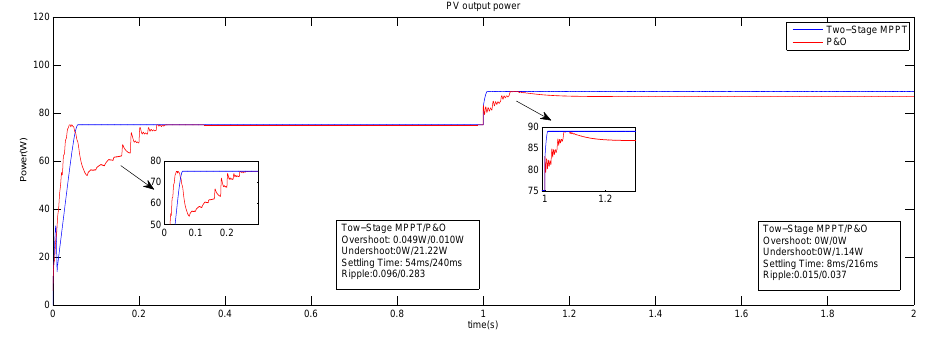
Figure 9. PV output power under temperature